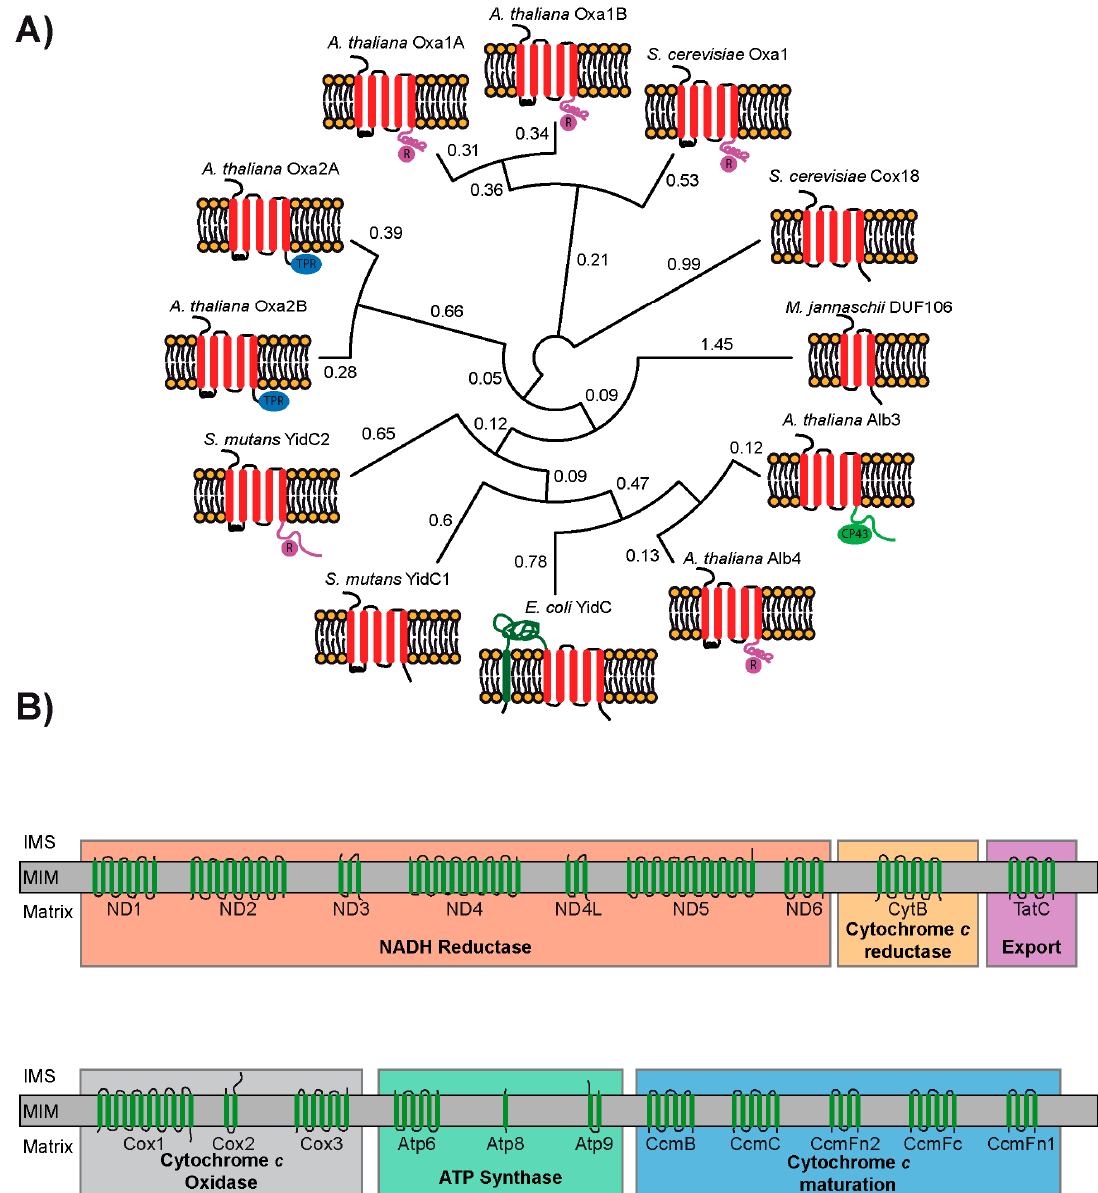
Figure 2. Phylogenetic and structural analysis of the YidC/Oxa1/Alb3 family and the mitochondrial-encoded membrane proteins of Arabidopsis thaliana . ( A ) A phylogenetic tree was generated by Clustal omega based on the full-length protein sequences for the indicated species of the YidC/Oxa1/Alb3 family [60]. The numbers next to each node represent the measure of support for the node. The conserved five TMH secondary structures are found in all members (except archaea) of the protein family. Differences at the C-terminal ends are indicated by different colors: pink = ribosome-binding, blue = TPR domain, green = CP43-interacting. ( B ) Transmembrane topologies of the 20 putative MIM proteins encoded in the mitochondrial genome of Arabidopsis thaliana . The proteins are displayed in an N- to C-terminus orientation going from left to right.